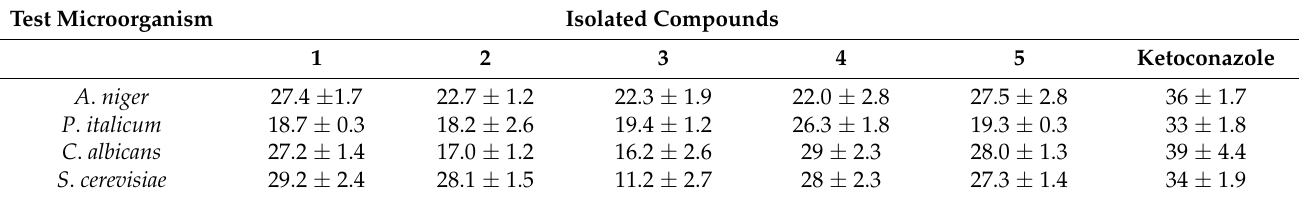
Table 3. Antifungal activity of six sufficient compounds isolated from the culture broth of A . punica 04107M (diameter of the zone of growth-inhibitory fungicidal zone is given in mm, including the diameter of the disk, which is 8